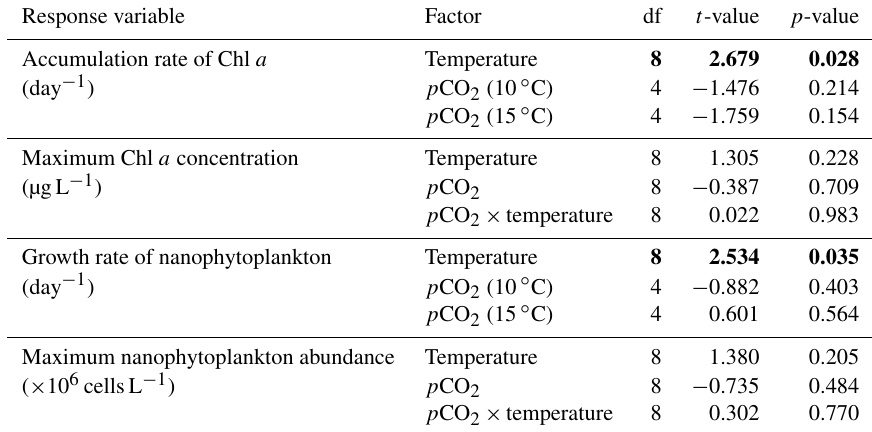
Table 3. Results of the generalized least squares models (gls) tests for the effects of temperature, p CO 2 , and their interaction. Separate analyses with p CO 2 as a continuous factor were performed when temperature had a significant effect. Accumulation rate of Chl a (day 0 to maximum Chl a concentration), maximum Chl a concentration, growth rate of nanophytoplankton (day 0 to maximum nanophytoplankton abundance), and maximum nanophytoplankton abundance. Significant results are in